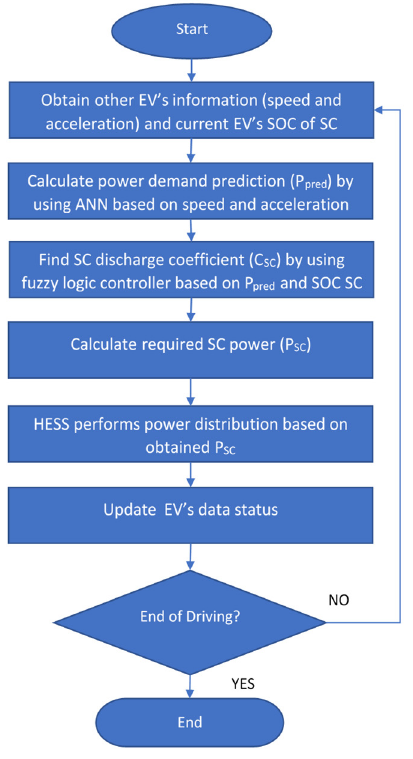
Figure 8. Hierarchical power management for connected EV.